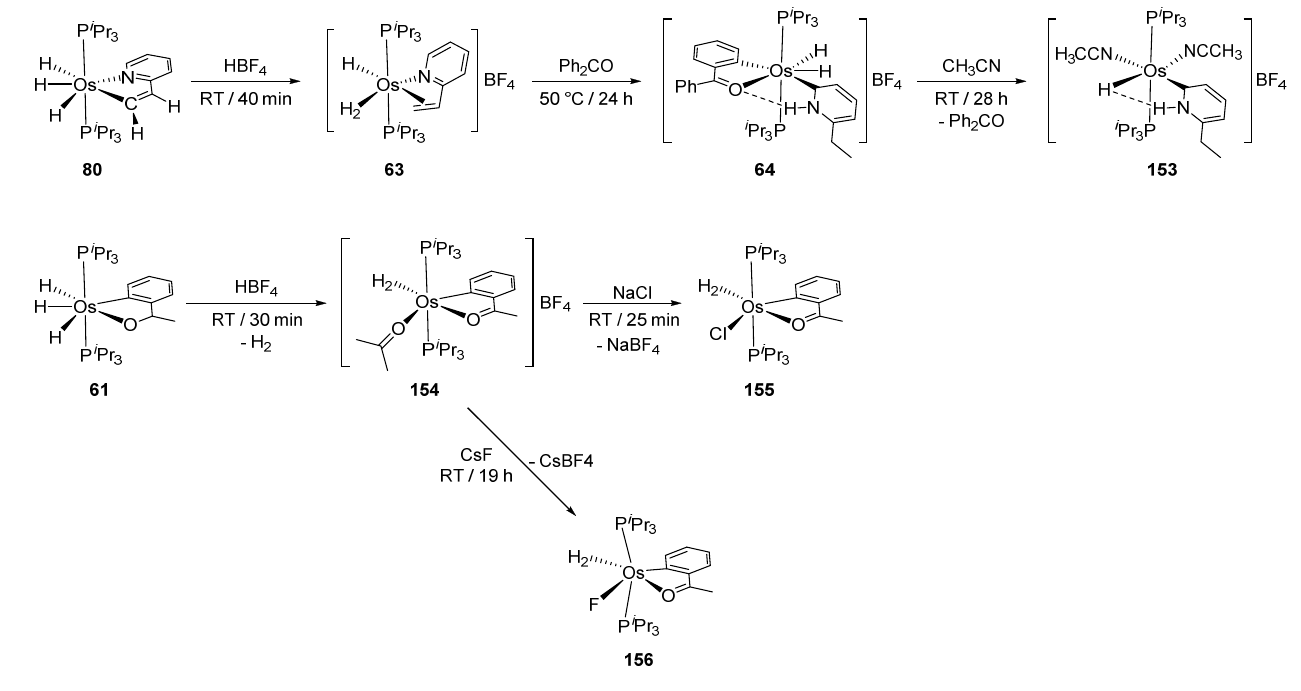
Figure 33. Reactions of hydride complexes with HBF 4 .